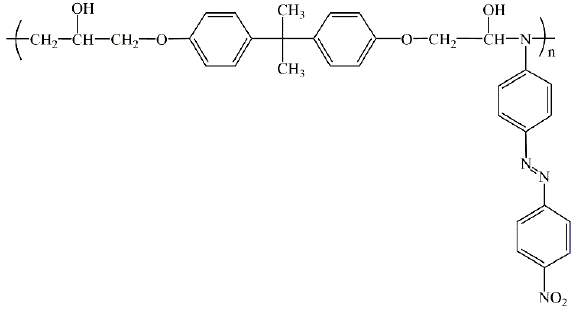
Figure 1. Chemical structure of polydisperse orange 3 (PDO 3 ).